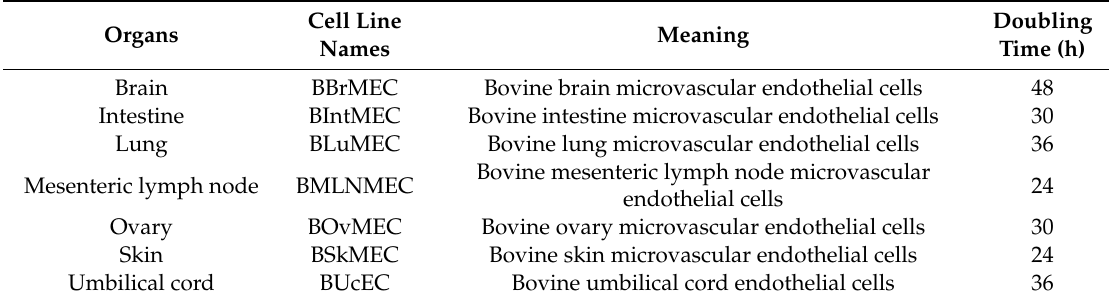
Table 1. Established bovine endothelial cell